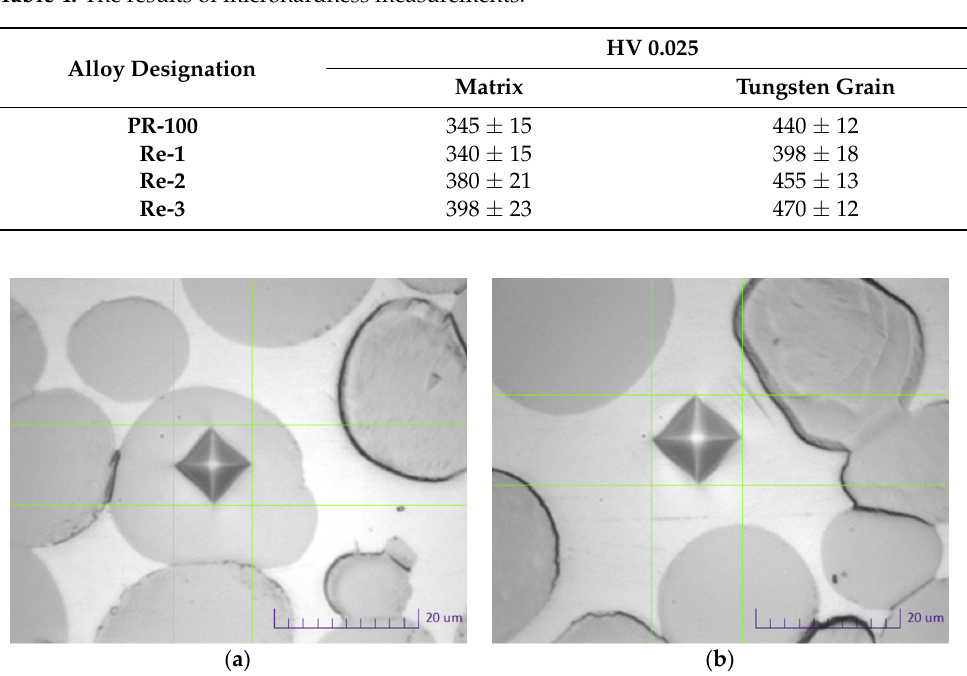
Table 4. The results of microhardness measurements.